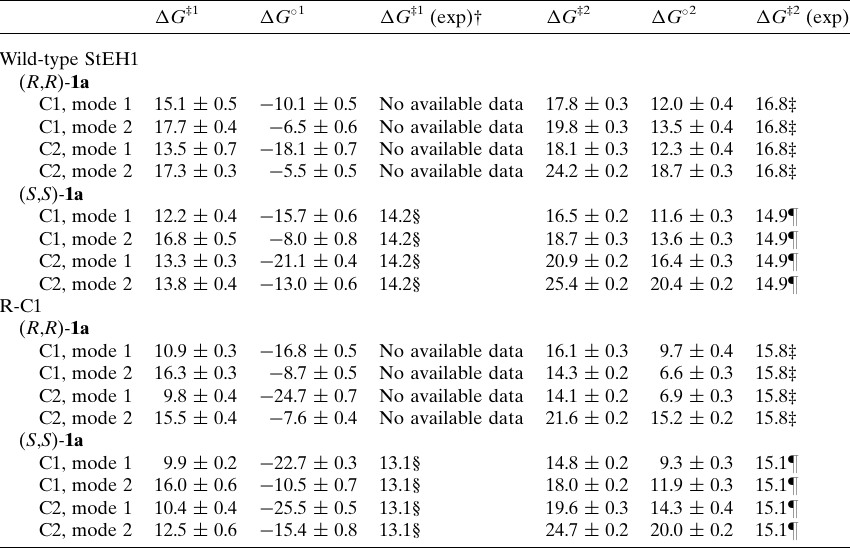
Table 4 Active-site volume analysis using POcket Volume MEasurer ( POVME ; Durrant et al. , 2011, 2014).